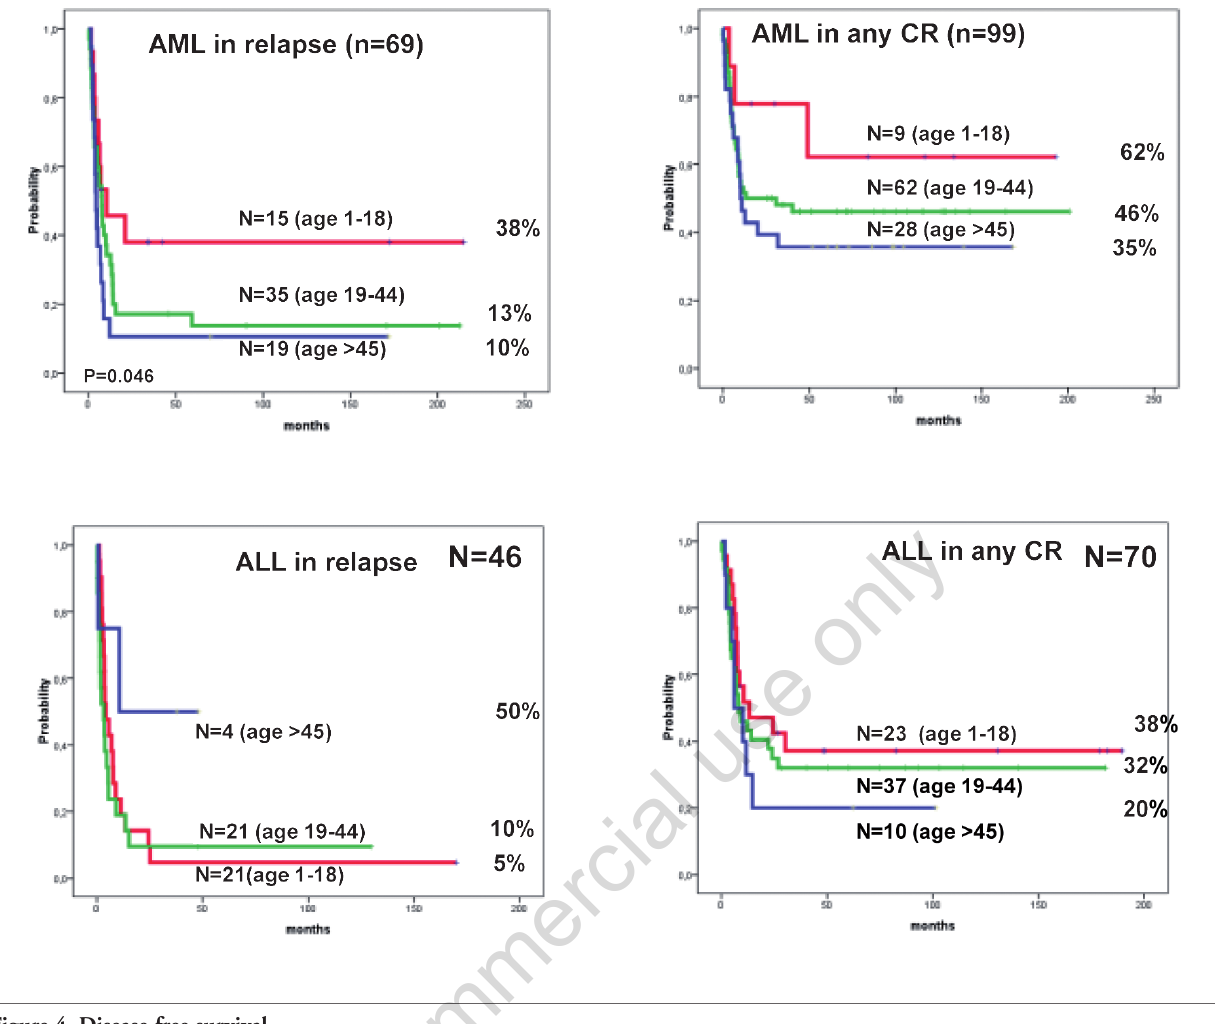
Figure 4. Disease-free